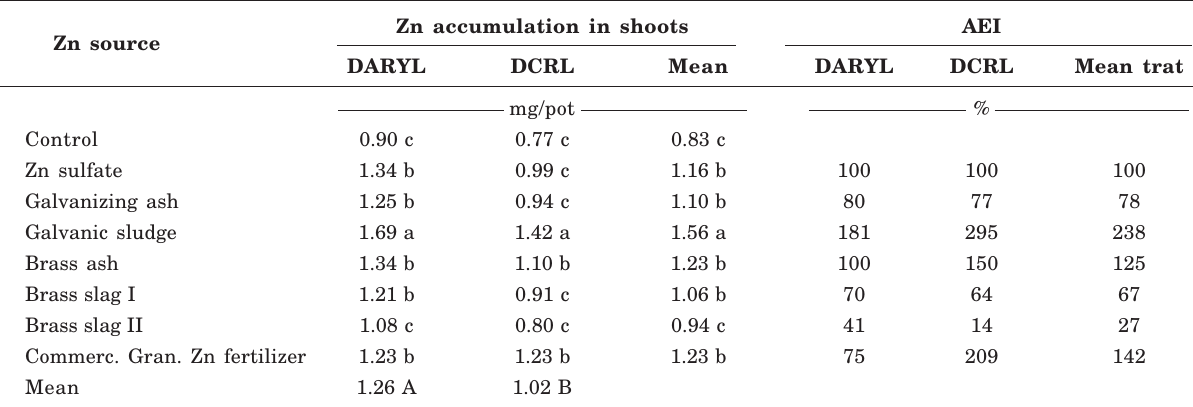
Table 7. Zn accumulation in maize shoots and agronomic efficiency index (AEI) of applied Zn sources compared to Zn sulfate (100